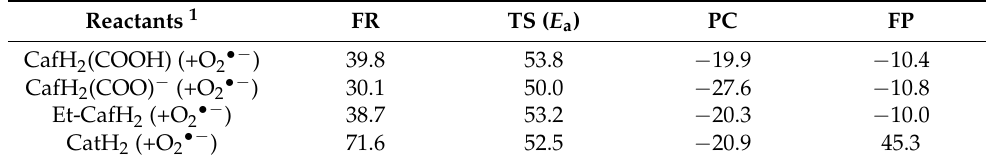
Table 2. ∆ G ◦ and E a values (kJ mol − 1 , 298.15 K) of the 2PCET between O 2 •− and the sub- strates (CafH 2 (COOH), CafH 2 (COO) − , Et-CafH 2 , and CatH 2 ) in DMF, calculated using DFT at the (U)B3LYP/PCM/6-311+G(3df,2p)